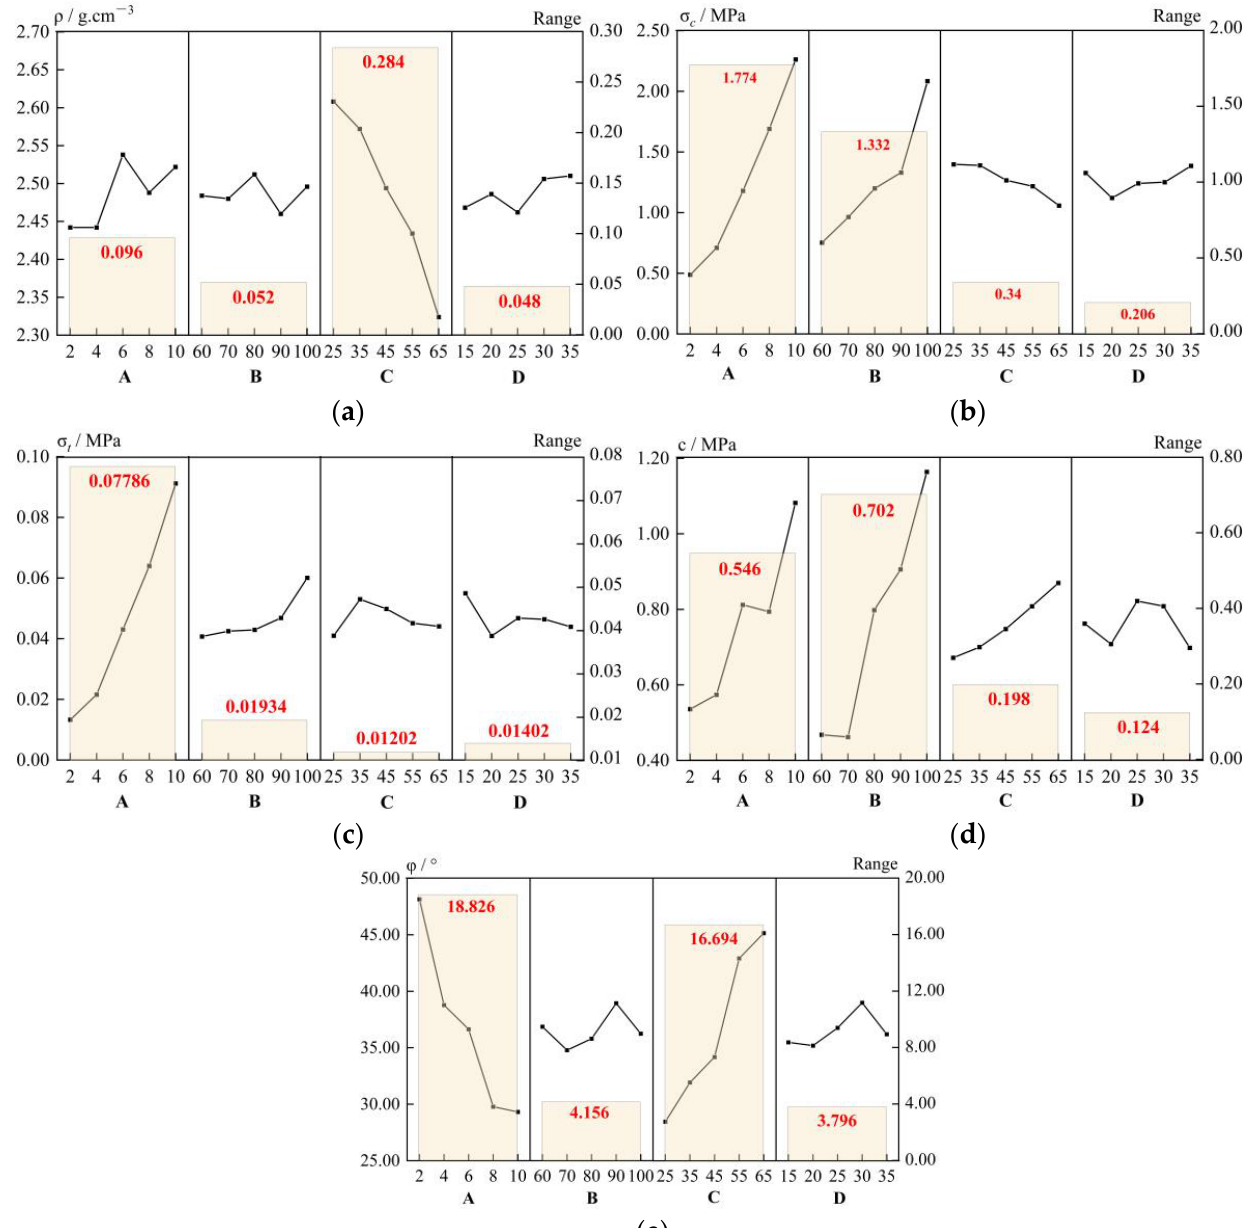
Figure 2. Range analysis of static physico-mechanical parameters. ( a ) Density; ( b ) compressive strength; ( c ) strength of extension; ( d ) cohesive strength; ( e ) internal friction angle.